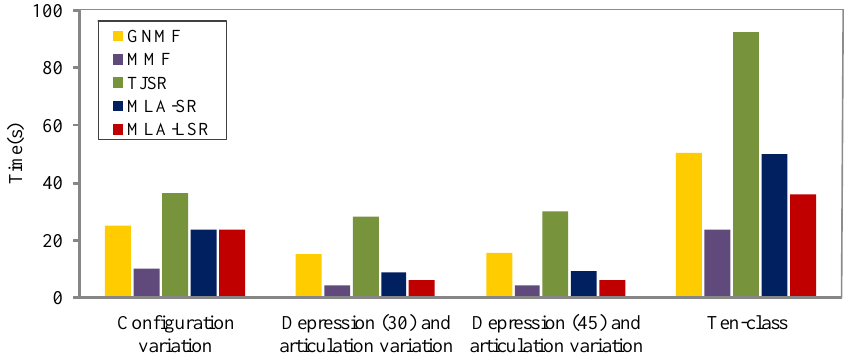
Figure 13. Comparison of the runtime of MLA-LSR with GNMF, MMF, TJSR and MLA-SR under different experimental